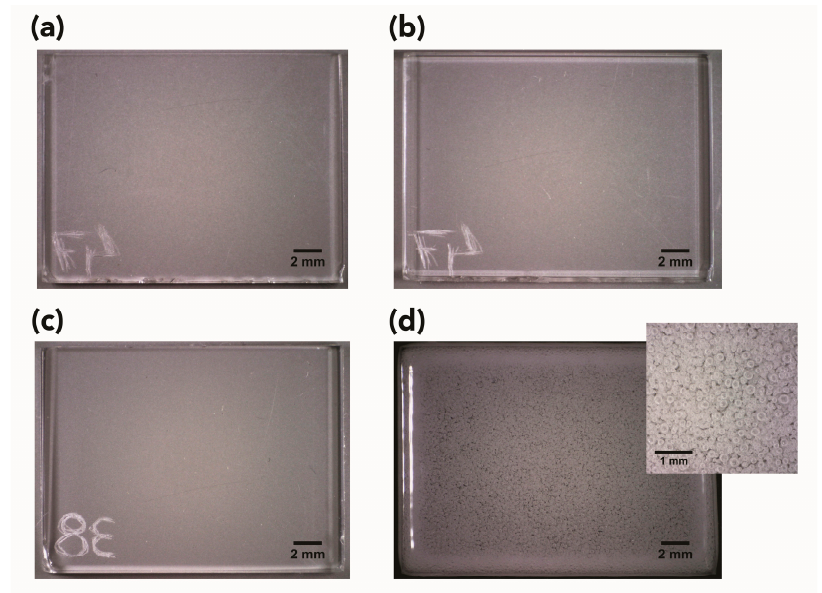
Figure 2. Representative digital photographs for PMMA samples ( a ) before and ( b ) after exposure to liquid CO 2 at 25 °C and 7 MPa (Test 5) and ( c ) before and ( d ) after exposure to CO 2 at 55 °C and 28 MPa (Test 4), showing the presence of extensive bubbles trapped in the sample’s bulk.